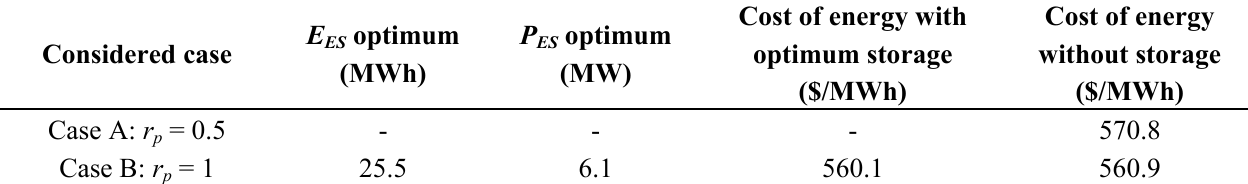
Table 3. Results of the energy storage optimization considering the advanced operation strategy for diesel generators ( P = 0.2) for different levels of wave power dmin